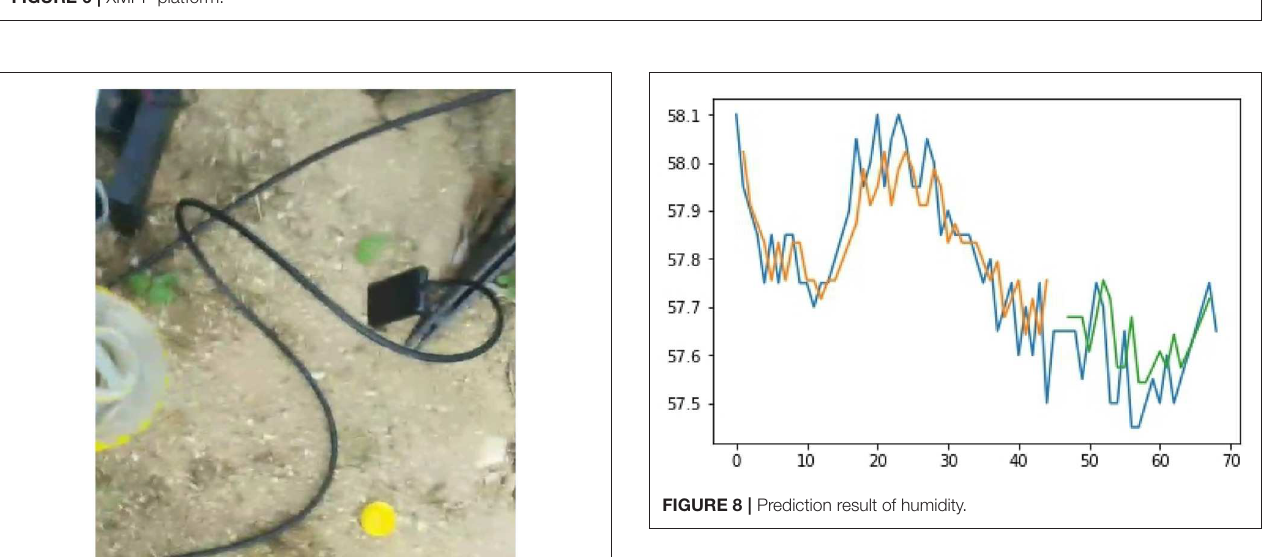
FIGURE 6 | XMPP platform.